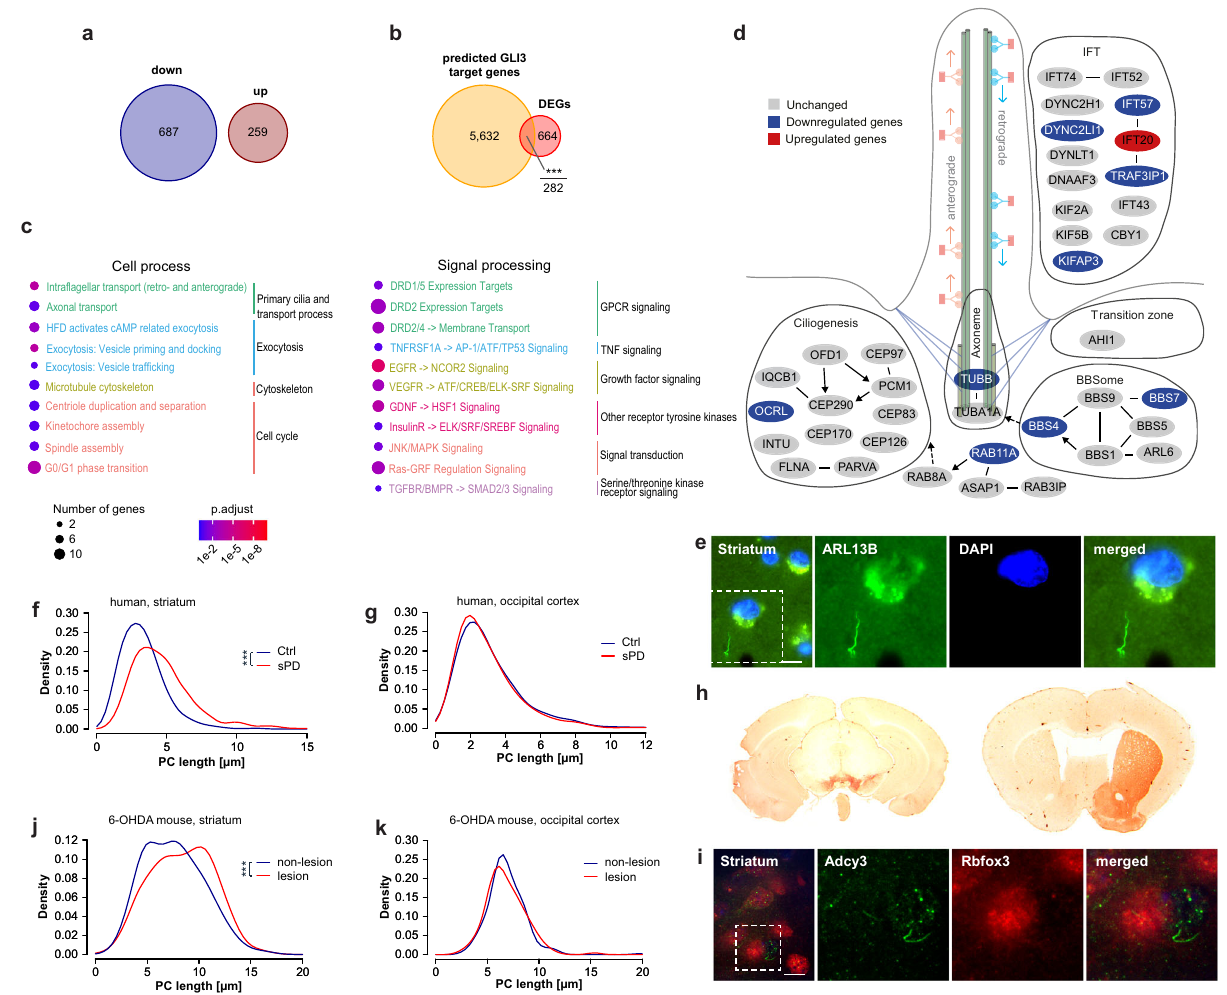
Fig.8|Primaryciliaassociatedgenesaredysregulatedinpostmortemtissueof sPD patients. a Number of up- and downregulated DEGs. b Overlap of genome wide predicted GLI3 target genes using the MatInspector (Genomatix) with DEGs. c Enriched pathwaysofthe categoriesCellprocess and Signalprocessinganalyzed using Pathway Studio for DEGs identi fi ed in a previously published meta-analysis ( n =83 PD patients and 70 Ctrl patients) of substantia nigra transcriptome studies 46 . P -values were determined by one-sided Fisher ’ s exact tests. FDR cor- rected p -values are represented by q -values. d Visualization of cilia associated DEGs. Up- (red) and downregulated (blue) genes are sorted into functional cate- gories intra fl agellar transport (IFT), transition zone, BBSome, axoneme, and cilio- genesis. e PC immunostaining with anti-ARL13B exemplarily shown for patient GA 2019/20 Ctrl-2. f Density plot illustrating PC length (in µ m) distribution in human striatum ( n =79-133 cilia per individual), and g occipital cortex ( n =75-105 cilia per individual). PC length was measured in paraf fi n embedded brain sections